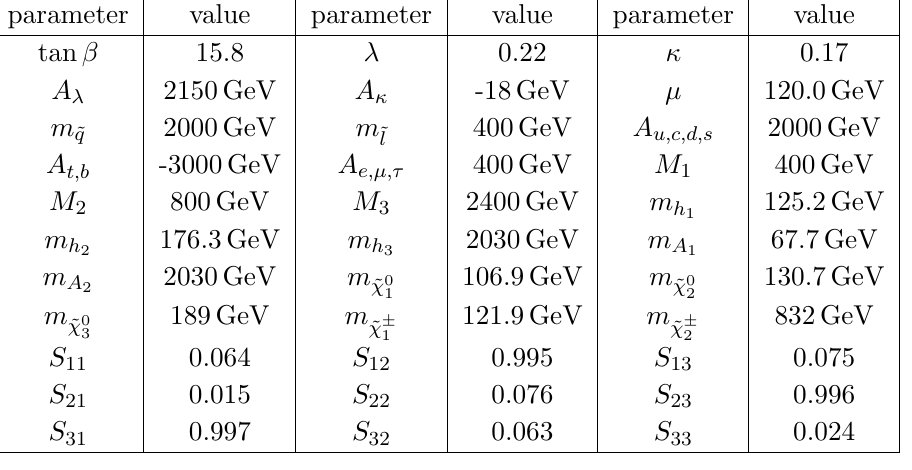
Table 2 . Fixed parameters in the NMSSM sector when we present our numerical results. In this table, h 1 acts as the SM-like Higgs boson, h 2 and A 1 are singlet dominated scalars, the mass degenerate h 3 and A 2 correspond to the heavy Higgs bosons in the MSSM, and S is the rotation matrix to diagonalize the mass matrix for the CP-even Higgs bosons in the basis ( H d ; H u ; s ). Note that since we have set the higgsino mass at 120 GeV, which is motivated by naturalness argument, and ~ (cid:31) (cid:6) are light with mass around 120 GeV. Also all the higgsino-dominated particles such as ~ (cid:31) 0 , ~ (cid:31) 0 1 2 1 note that the masses for the Higgs bosons are slightly altered by the parameters in sneutrino sector through loop e(cid:11)ects, so their values in this table are actually obtained for the case of Y (cid:23) = (cid:21) N =